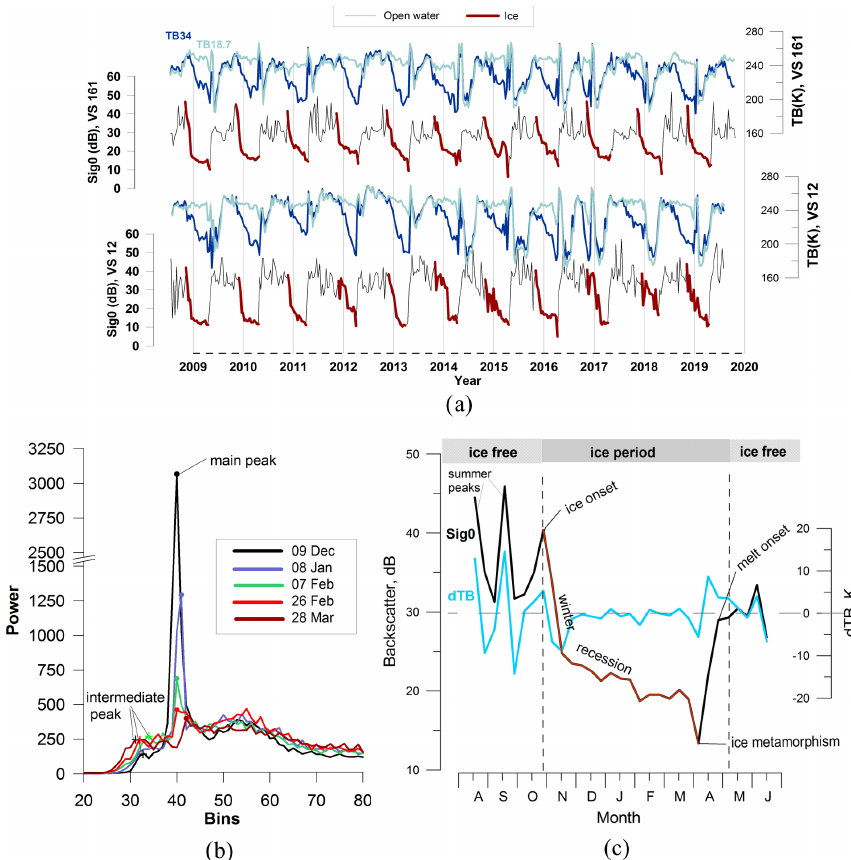
Figure 3. Variability of Jason-2 and Jason-3 measurements over sections of the Ob River: (a) interannual variability of backscatter and brightness temperature to the north (VS 161) and south (VS 12) of the study area (dark-red lines correspond to the ice cover period retrieved from altimetric measurements using the manual routine), (b) winter evolution of typical waveforms for track 88 over a river channel (coloured lines correspond to different dates during winter 2013–2014), and (c) typical seasonal variability of backscatter on the Ob River and related ice regime